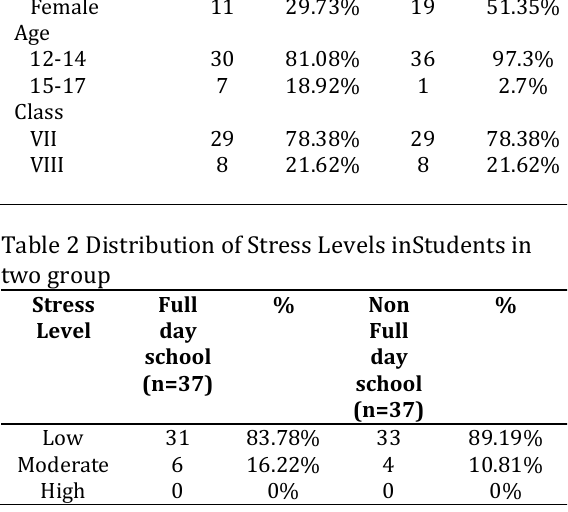
Table 3. Relationship Distribution between of a Full